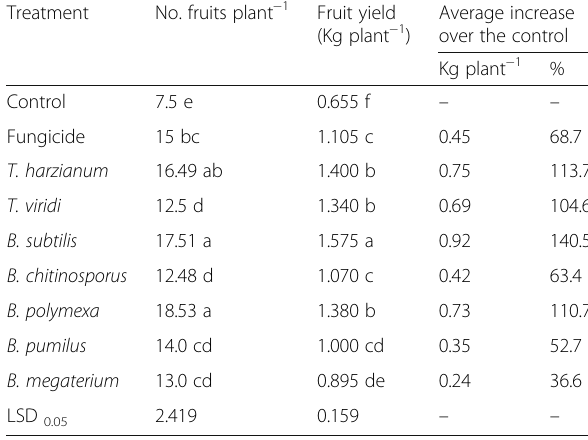
Values are means of three replicates of each treatment Means values for each parameter followed by different letters are significantly different ( P ≤ 0.05), according to Duncan ’ s multiple range